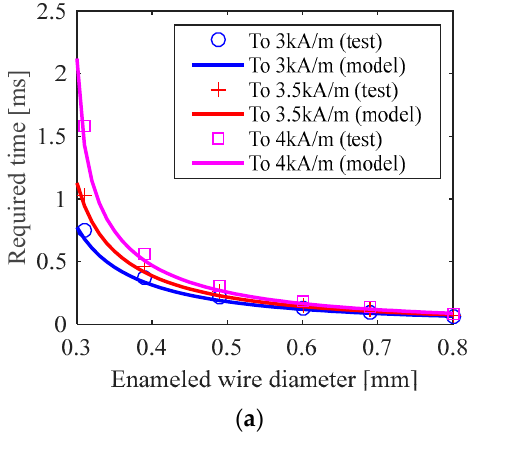
Figure 11. The response time of the square-wave response from the test and model: ( a ) the time from 0 to specified intensities, respectively, of 3 kA/m, 3.5 kA/m, and 4 kA/m; ( b ) the time from 0 to the specified proportions of the steady-state response, respectively, of 0.7, 0.8, and 0.9.